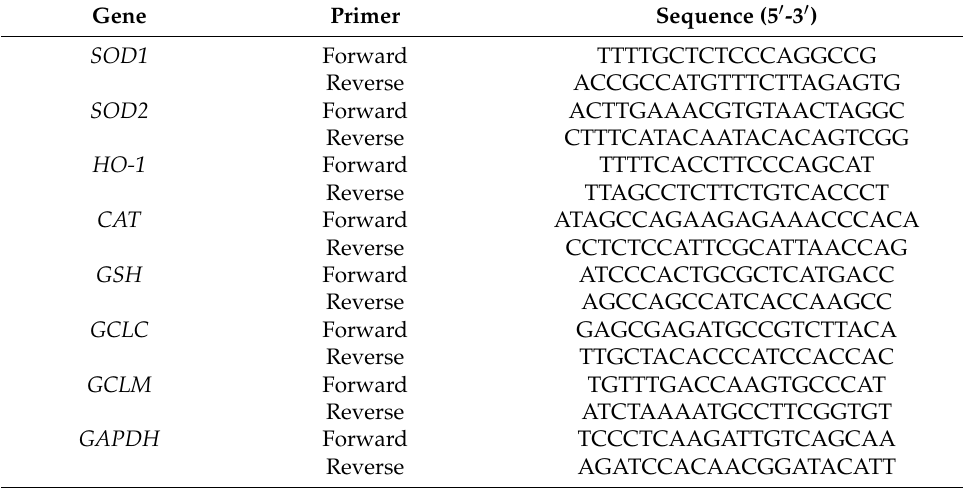
Table 1. Genes and primers selected for RT-qPCR.